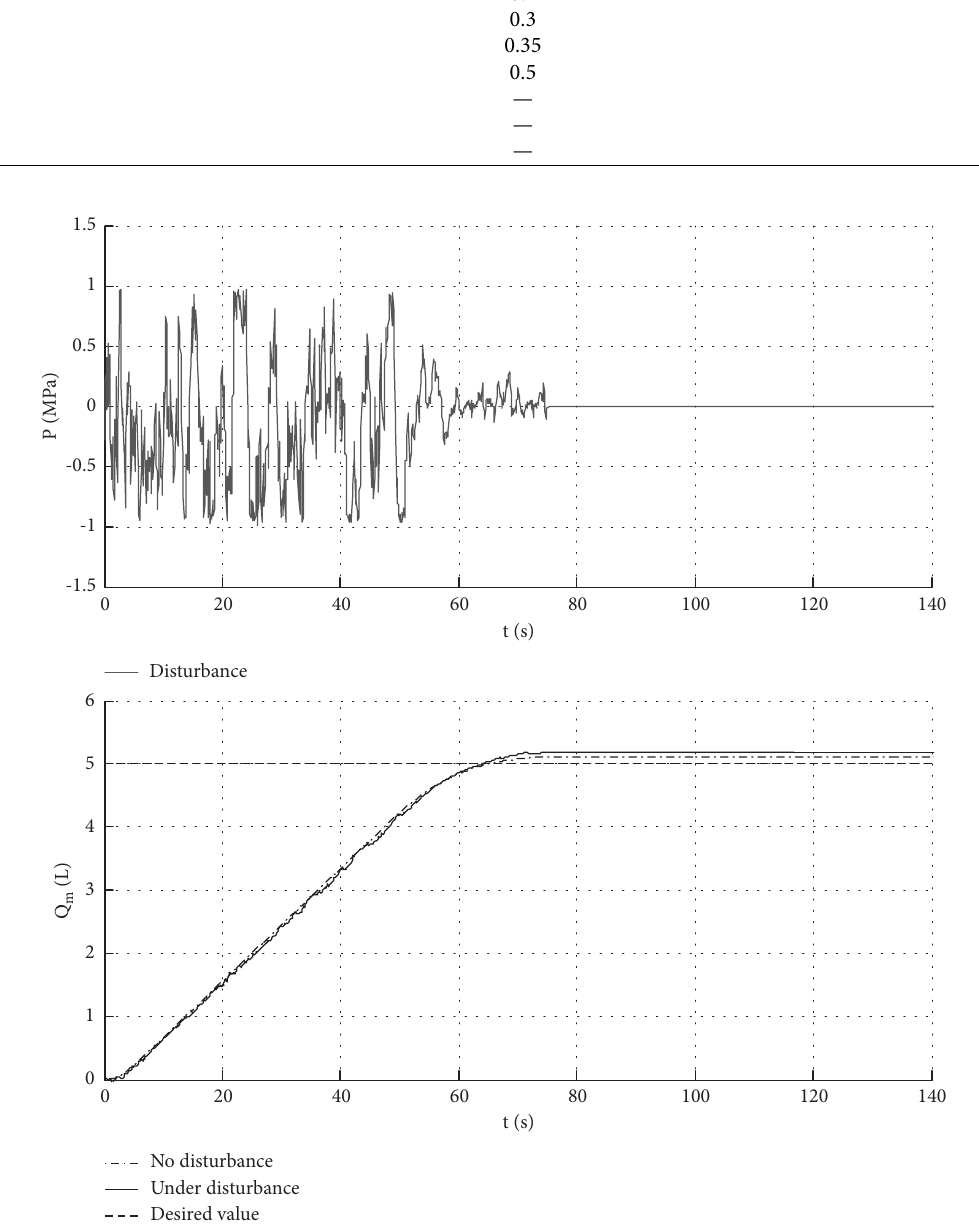
Figure 9: Response curve of the fuzzy sliding mode controller under disturbance.